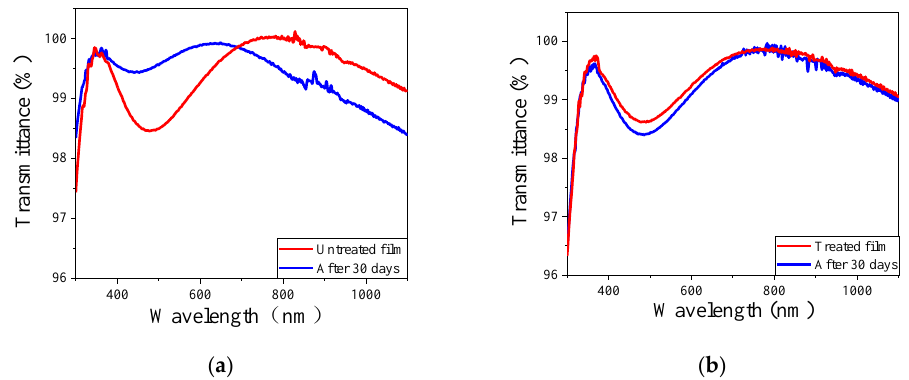
Figure 10. The water contact angle of untreated ( a ) double-layer broadband film and the film after treatment ( b ).